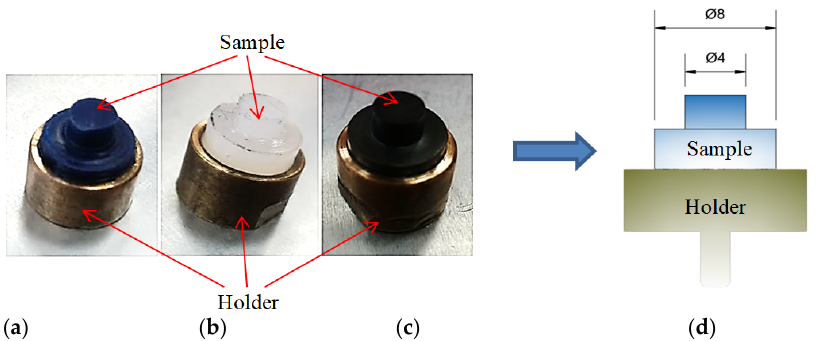
Figure 1. Samples of tested materials: ( a ) PE-HD, ( b ) PA6, ( c ) PEEK/BG, ( d ) scheme of polymer sample placed in holder.